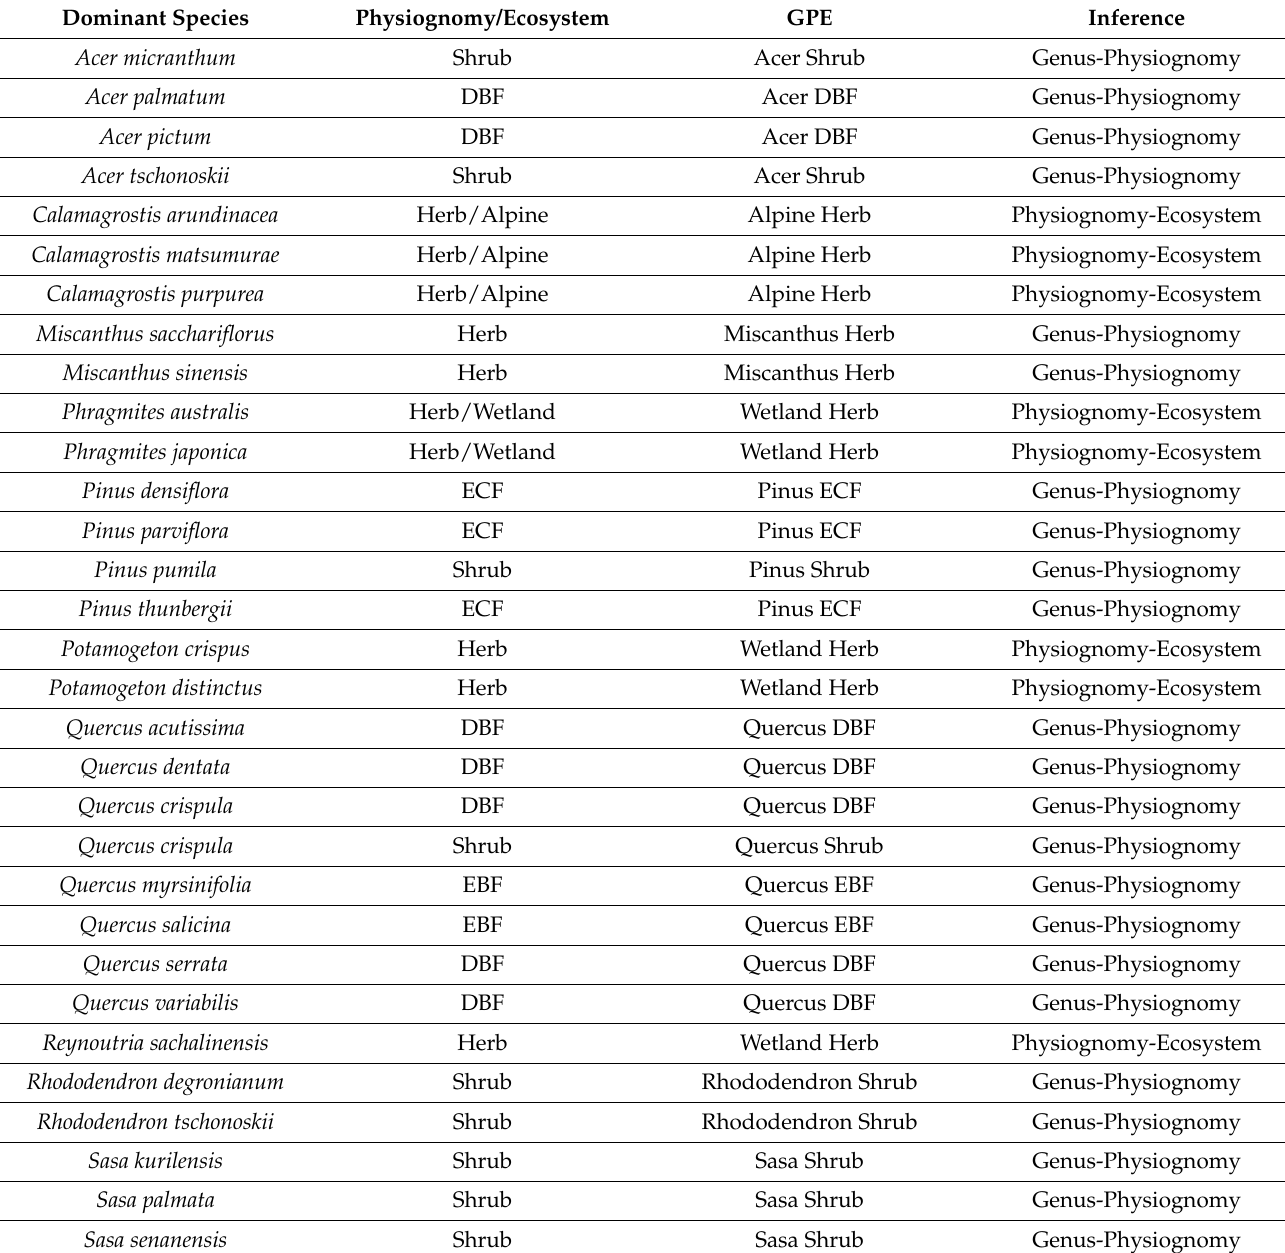
Table 2. Implementation of genus and physiognomy/ecosystem inferences on the dominant species. Dominant